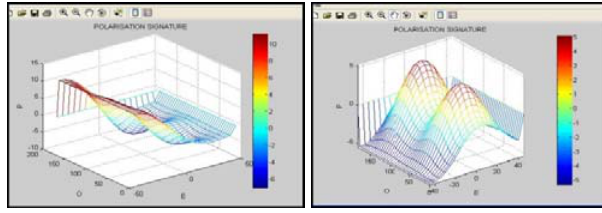
Co-polarized Signature Cross-polarized Signature Figure 3.3(a): Polarimetric response of Vegetated